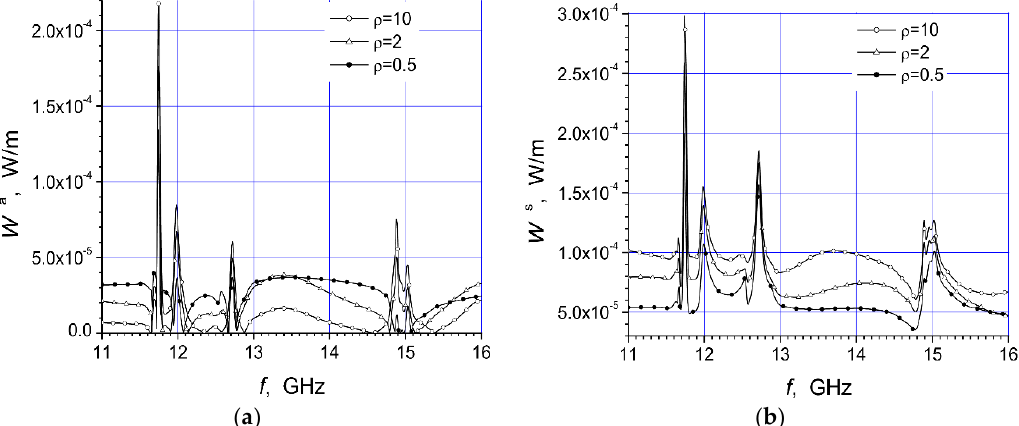
Figure 2. Dependencies of absorbed power ( a ) and scattered power ( b ), of the array Figure 1a, on the frequency of the parallel polarized incident wave at R = 12 mm.